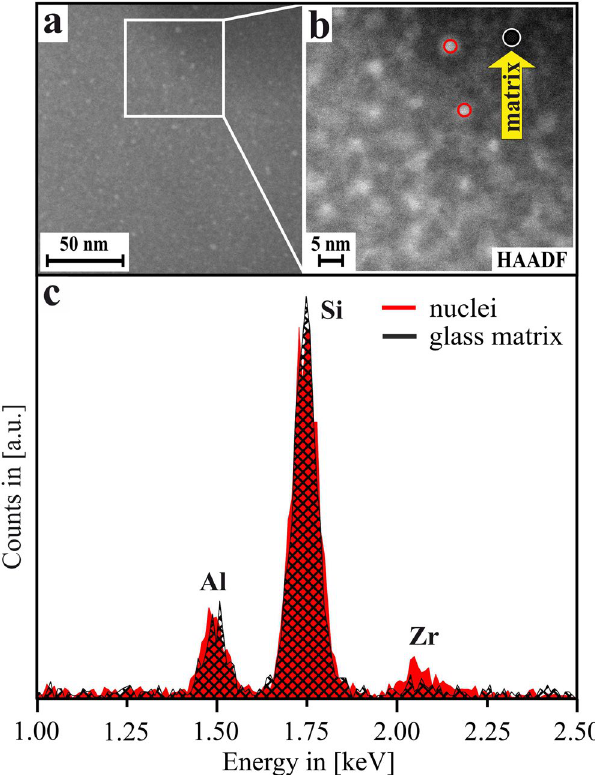
Figure 3. ( a ) STEM micrograph of a sample thermally treated at 725 °C for t = 0.25 h. ( b ) Detailed view of the inset shown in ( a ). ( c ) STEM-EDX spectra of different sample areas, as highlighted in ( b